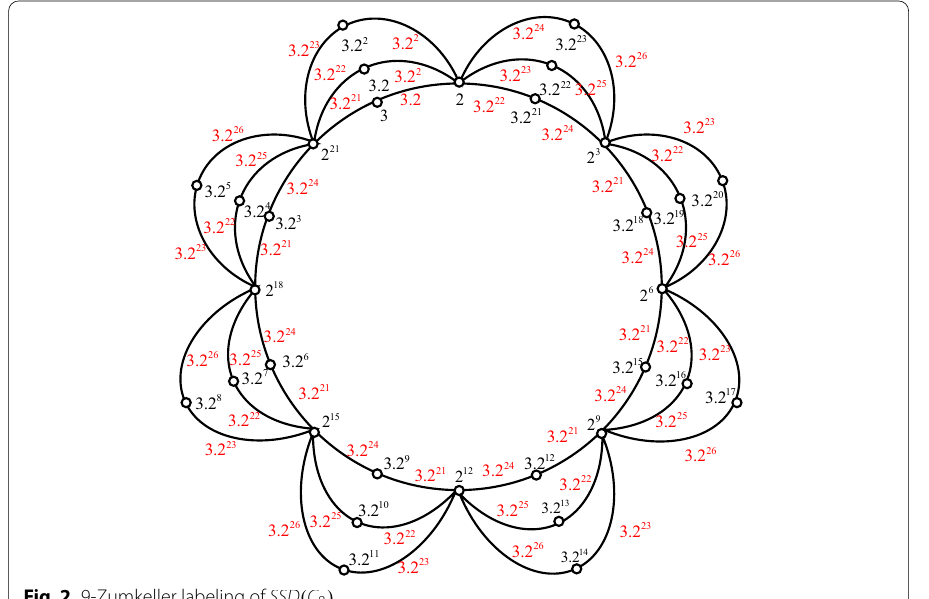
Fig. 2 9-Zumkeller labeling of SSD ( C 8